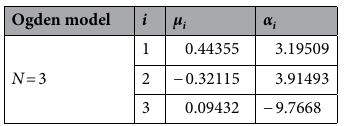
Table 4. Ogden model parameters of matrix.